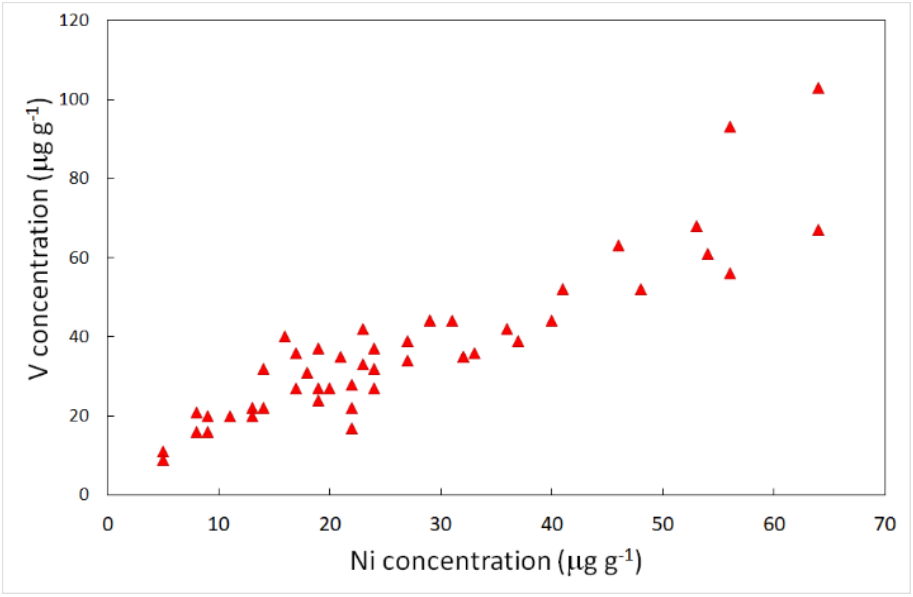
Figure 6. Relationships among Ni and V concentrations in lichen samples. Data are given in μ g g − 1 .